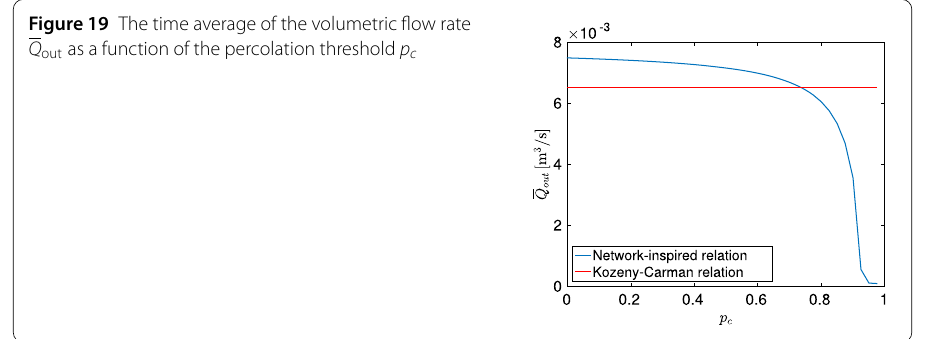
Figure 19 The time average of the volumetric flow rate Q out as a function of the percolation threshold p